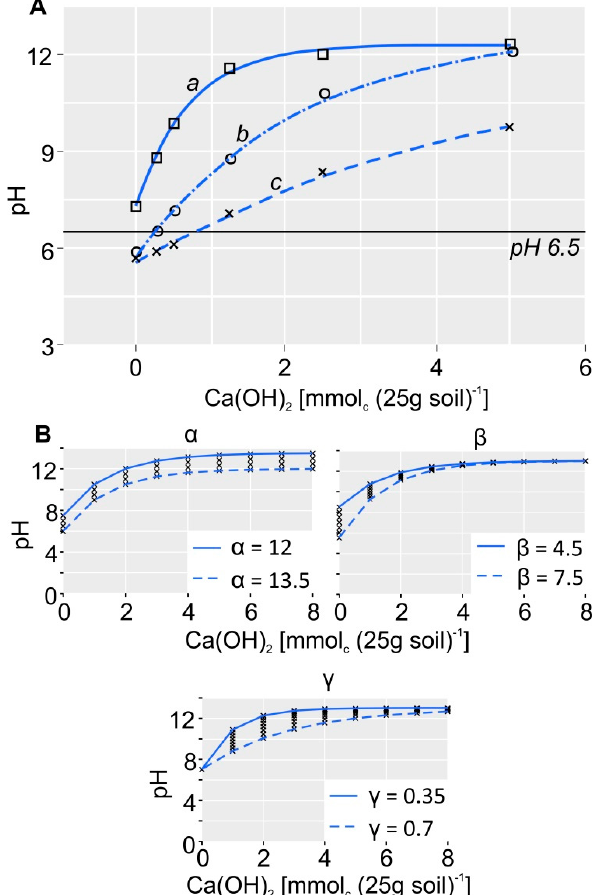
Figure 2. Examples of the BNC titration curves: ( A ) the range of BNC titration curves (a, b, c) from the investigated soils. The solid black line indicates the target pH of 6.5. ( B ) the influence of the correlation coefficients of the exponential function ( α , β , γ ) on the shape of the titration curve. Table 3. Correlation matrix of the regression coefficients of the exponential function using Spearman’s Rho.